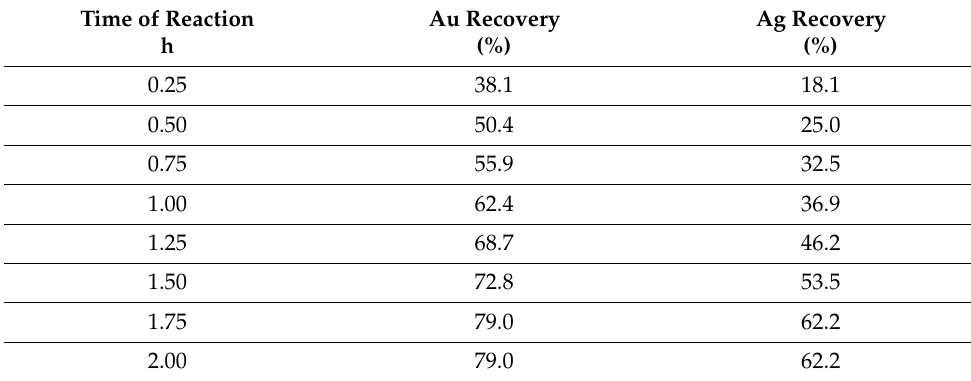
Table 5. Gold and silver recovery as a function of time by electrowinning. Time of